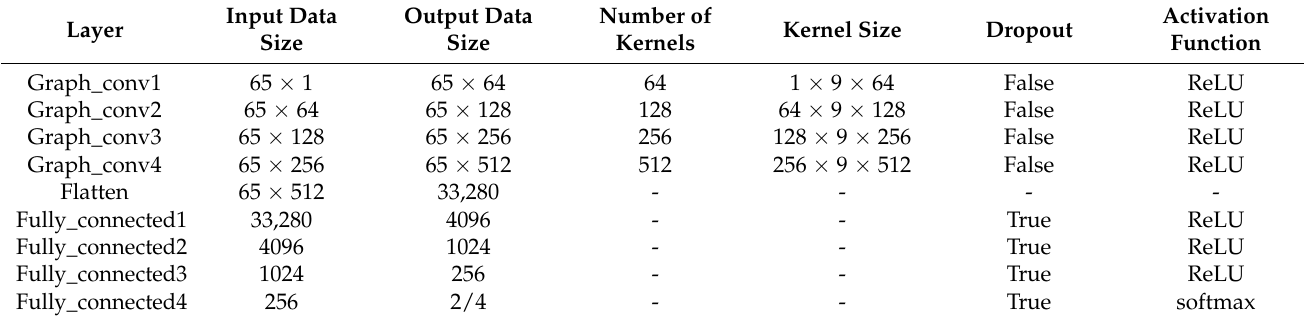
Figure 2. Architecture of the proposed GCNN model. Table 4. Details of the structure of the proposed GCNN model.